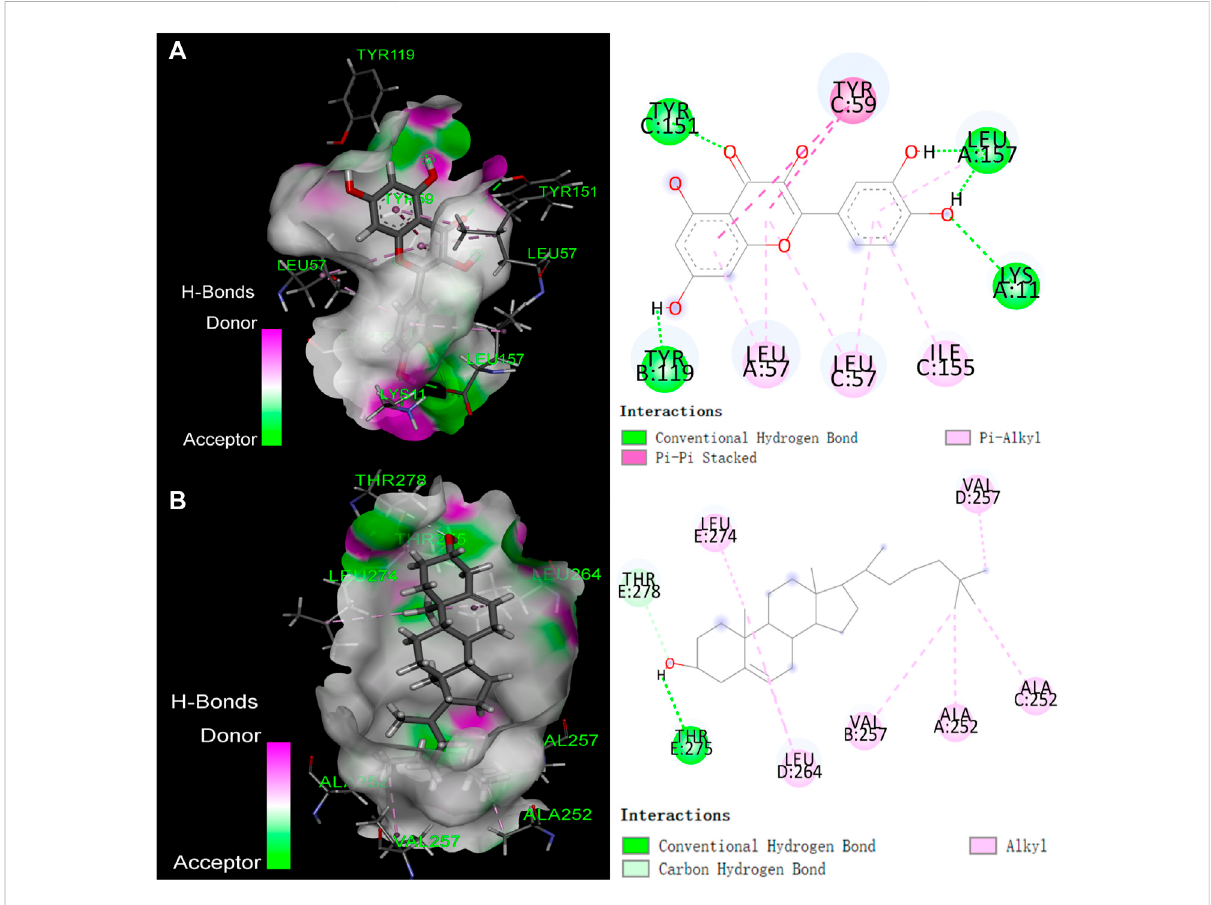
FIGURE 7 The binding mode of compounds with target proteins. (A) Quercetin-TNF; (B) β